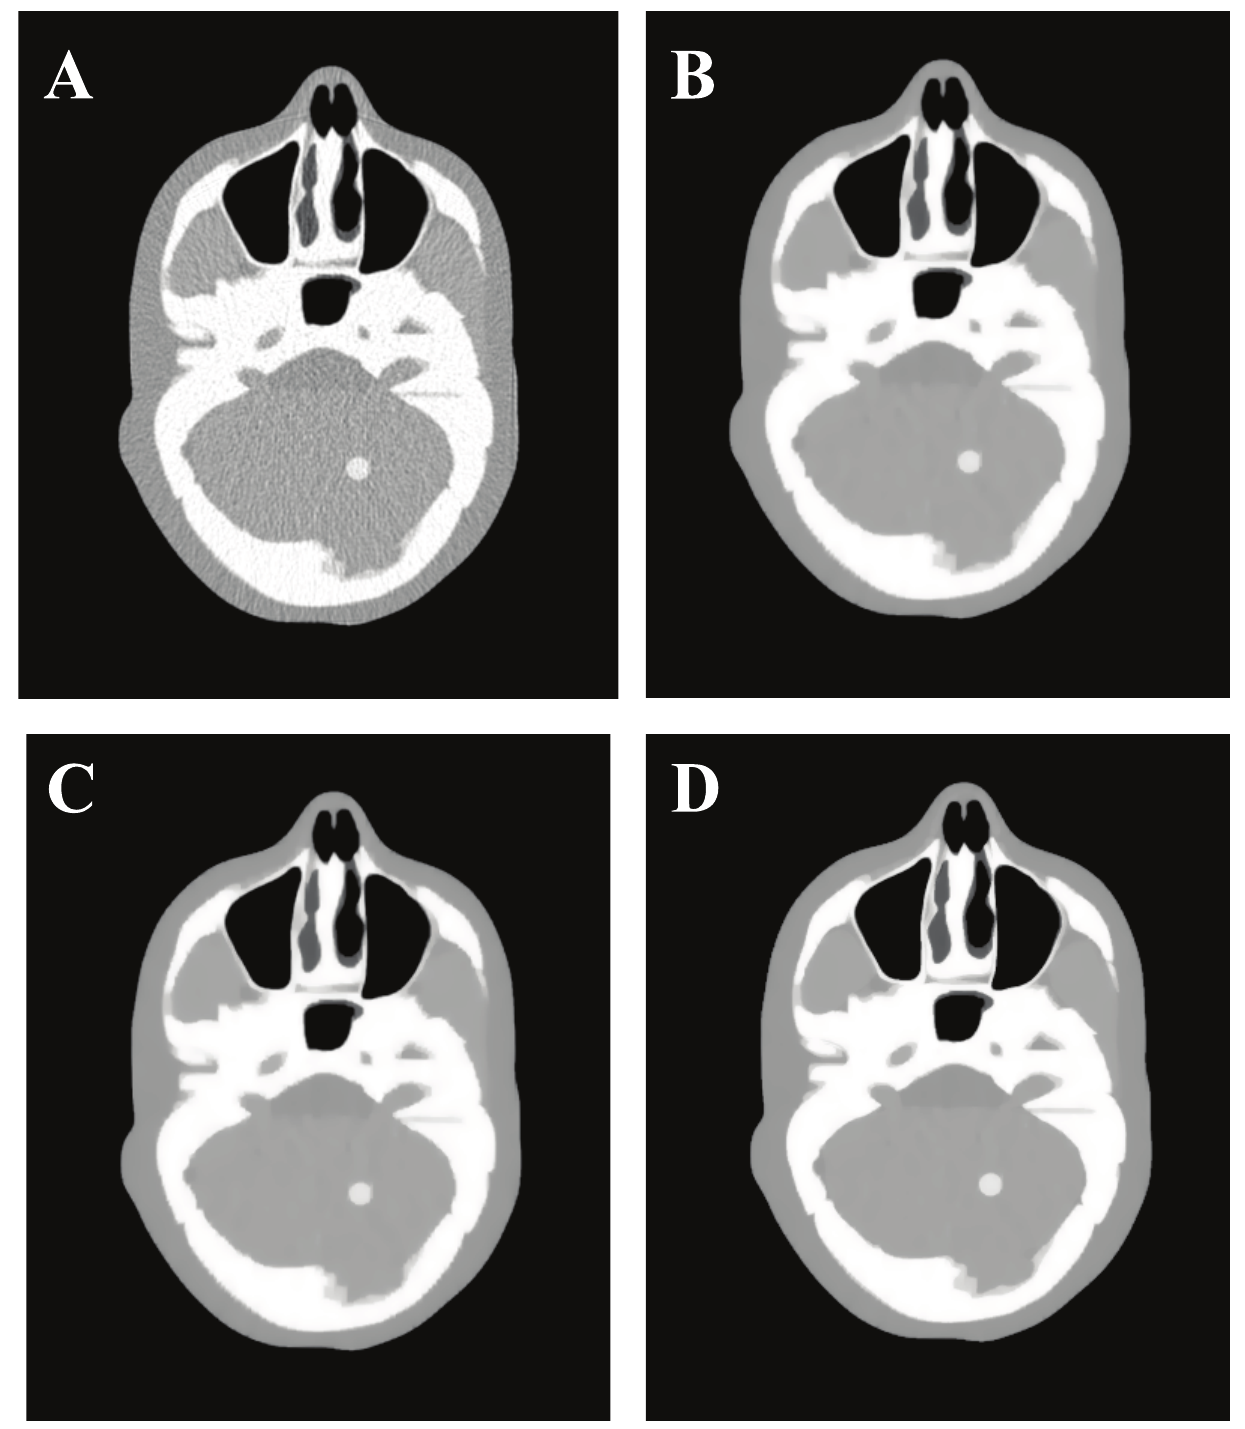
Fig 1. The XCAT phantom results reconstructed by four different algorithms from the same noisy sinogram data. (A) is the result from the FBP method with ramp filter; (B) is the result from the NCG algorithm with s = 1.0 × 10 − 2 , β = 2.0 × 10 4 ; (C) is the result from the SB-NCG algorithm with s = 1.0 × 10 − 3 , γ = 128, β = 8.0 × 10 3 ; and (D) is the result from ALM-ANAD algorithm with s = 1.0 × 10 − 3 , γ = 200, β = 2.0 × 10 3 . All images are displayed with the same window [0.0048 0.0128] mm − 1